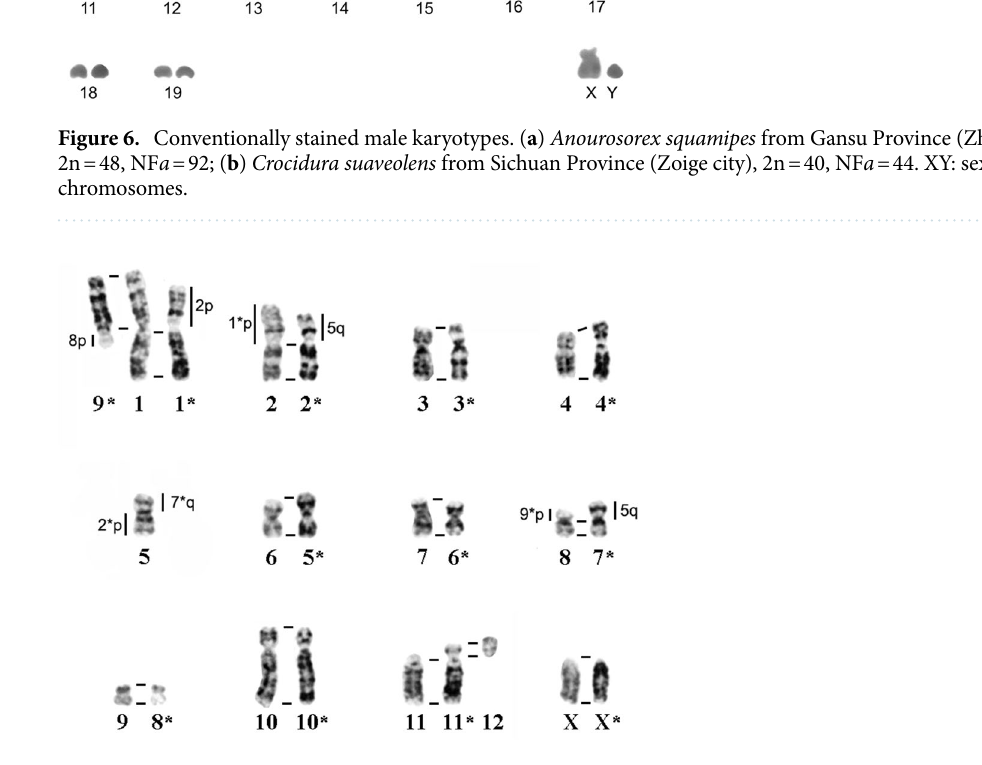
Figure 7. G-band matching between Sorex bedfordiae karyotypes. Homologous chromosomes of the 2n = 26 specimen presented in this paper (from Sichuan Province, Songpan County, Xiaobaosi vil.) are numbered in accordance with the Fig. 3, while those of a 2n = 24 specimen (taken with permission from Ref. 13 ) are marked by an asterisk. Homologous regions are indicated by vertical and horizontal lines. XX: sex